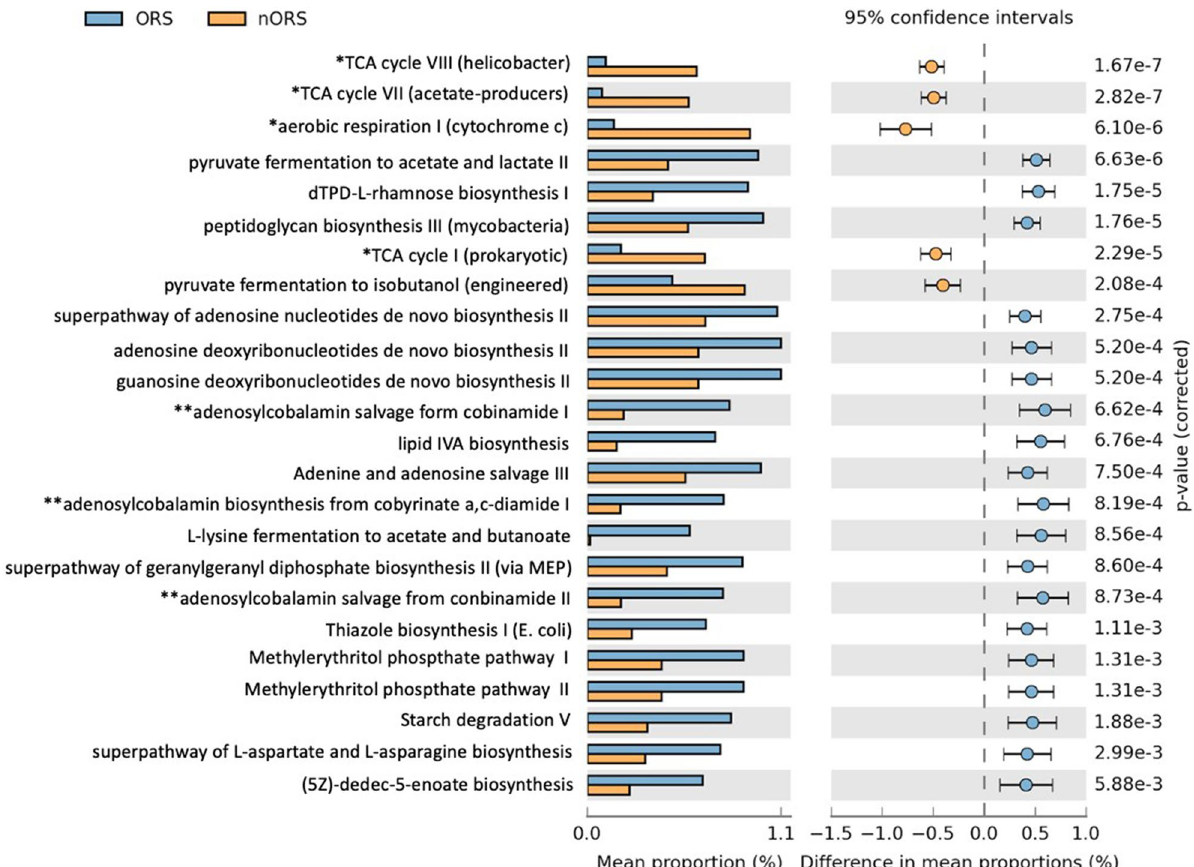
Figure 5. Functional analysis of the microbiota in ORS and nORS samples. *TCA related pathway and aerobic respiration pathway are dominant in nORS group. **Adenosylcobalamin biosynthesis related pathways are dominant in ORS